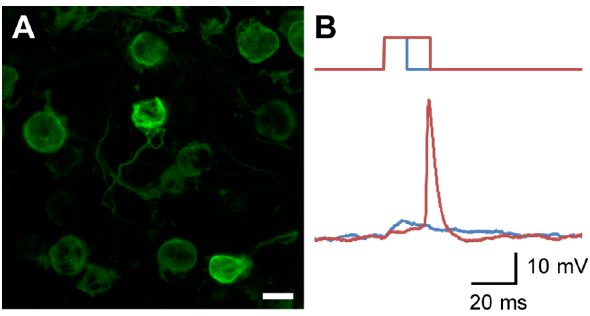
Figure 4. Direct optogenetic stimulation of calyx-type pre- synaptic terminals. A , Calyx-type presynaptic terminals expressing ChRFR-EGFP. Scale bar, 20 m m. B , Direct photostimulation with laser pulses of 10 ms (blue) and 20 ms (red) in the presence of 4-AP (1 mM). The resting potential, 2 53 mV; the action potential, 43 mV; the input resistance, 74 M V .